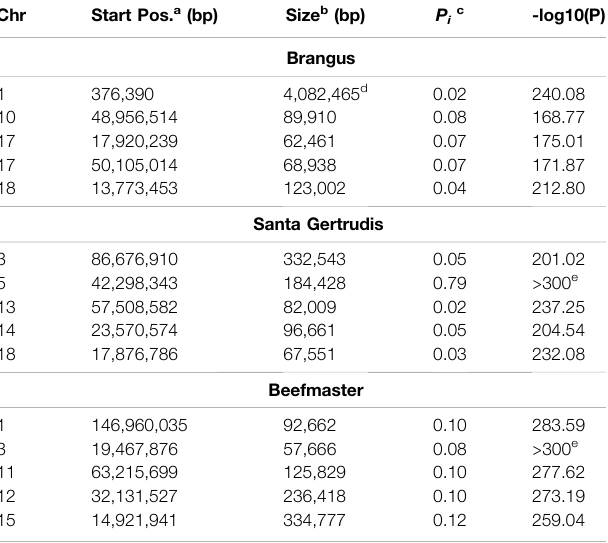
TABLE 4| Five most signi fi cantly diverged regions from expected Brahman breed proportion by breed. Chr Start Pos. a